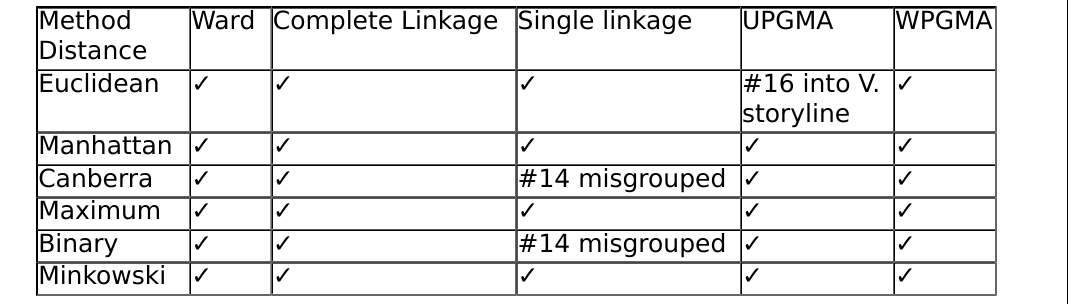
Table 3: Summary of results for five hierarchical clustering methods used in combination with six different distance functions. For the Minkowski distance, several different values for the parameter p were tried (3-5, 10, 30), with generally similar (positive)